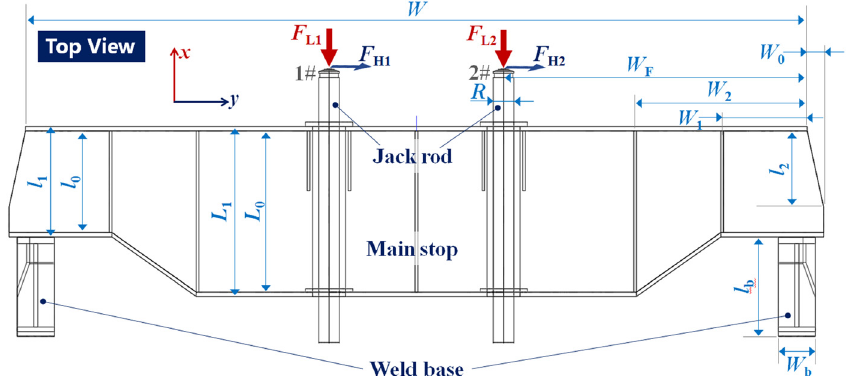
Figure 3: Geometric dimension of longitudinal stop beam.